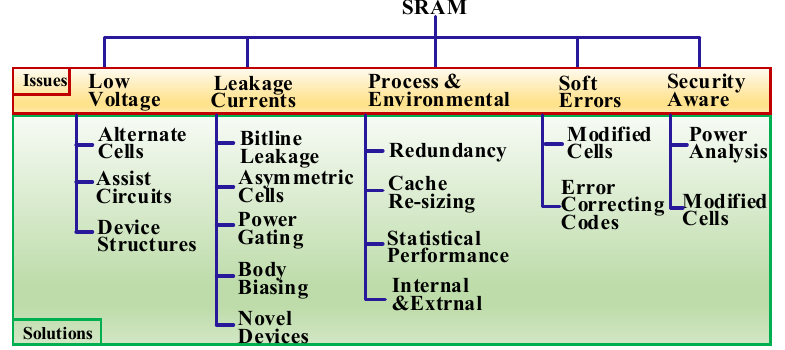
Figure 1. Computer memory classifications based on data retention.